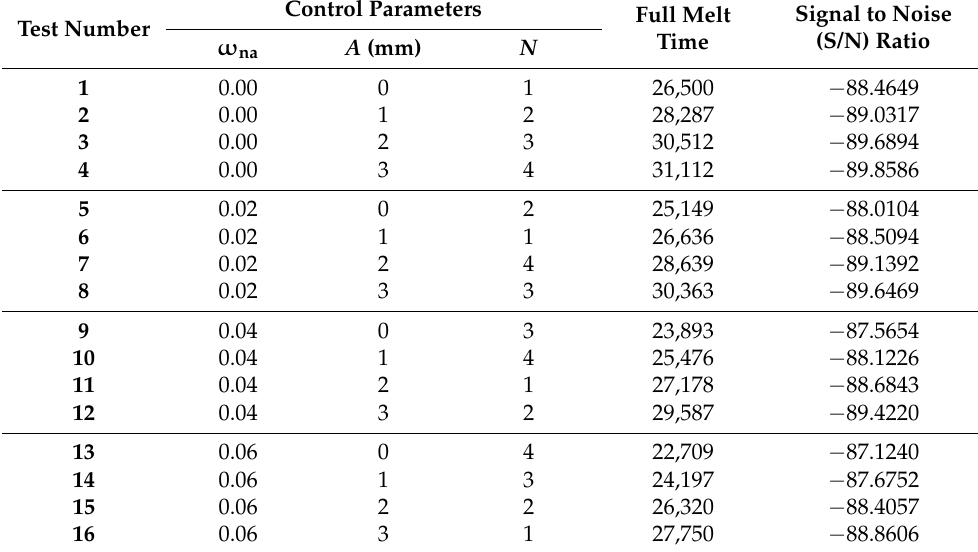
Table 4. Taguchi 16 orthogonal table corresponding to range and levels of control